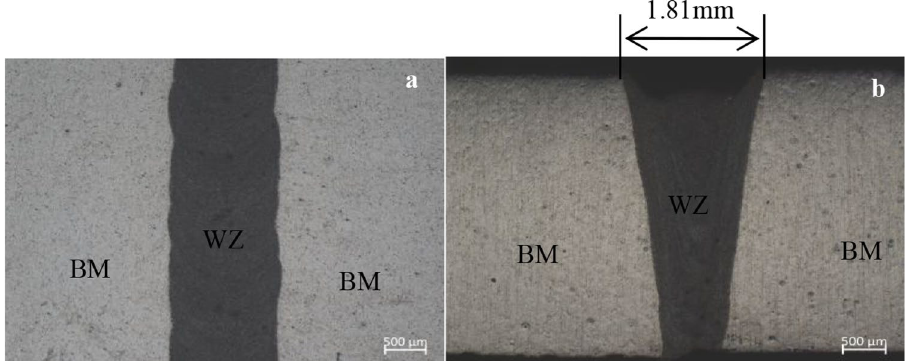
Fig. 3 Morphology of WE43 magnesium alloy EBW joint: a the front, b the